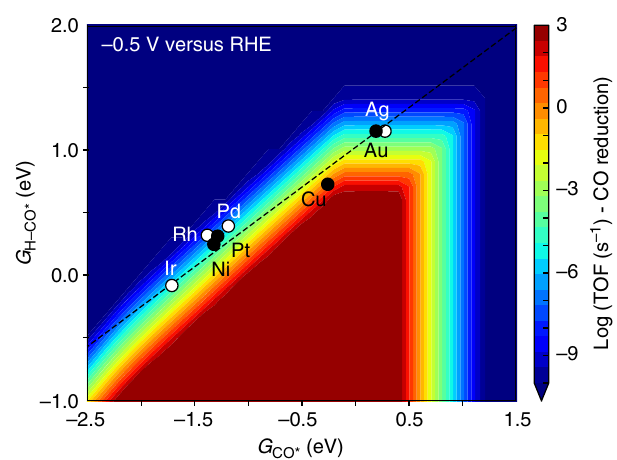
Figure 5 | 2D map of the rate of CO reduction as a function of H–CO transition state energy and CO binding energy. Performed at a potential of (cid:2) 0.5V